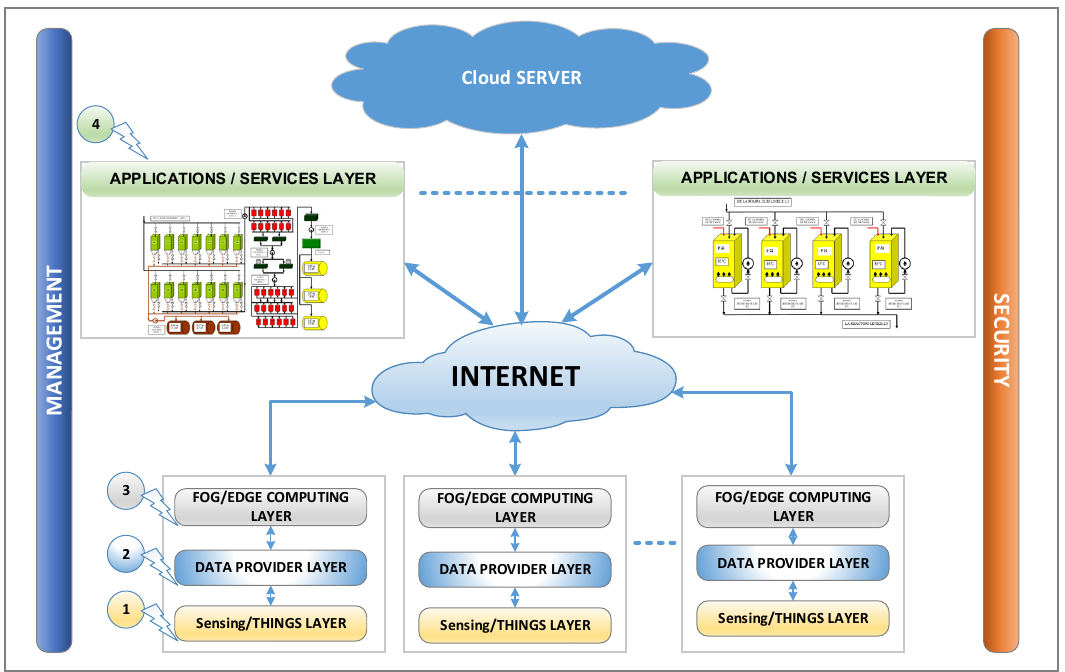
Figure 1. The proposed Industrial Internet of Things (IIoT) architecture. 1 Sensing / things layer, 2 Data provider layer, 3 Fog / edge computing layer, 4 Applications / services layer.